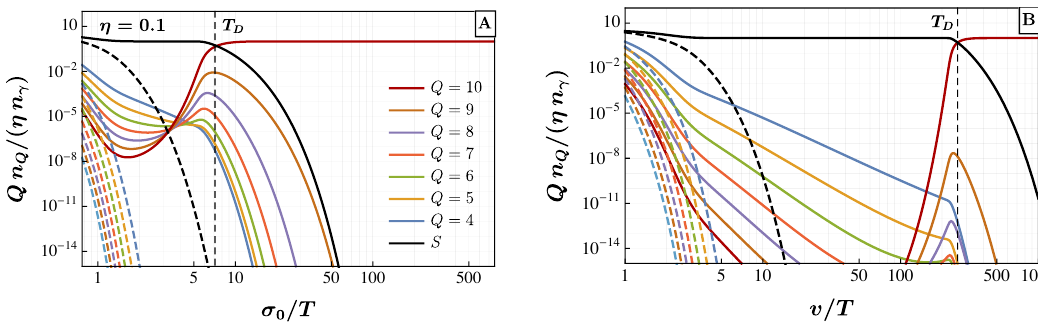
Figure 2 . The evolution of the equilibrium distribution of global charge for Model A with mass spectrum in (2.2) (left panel) and Model B with mass spectrum obtained numerically (right panel) using model parameters from (2.11). For both panels, η = 0 . 1 , Q min = 4 , and Q max = 10 . The solid curves represent the evolution of S and positively-charged solitons ( Q ) , while the dashed curves are for S † and negatively-charged solitons ( − Q ) . The vertical dashed lines indicate T D as analytically estimated in